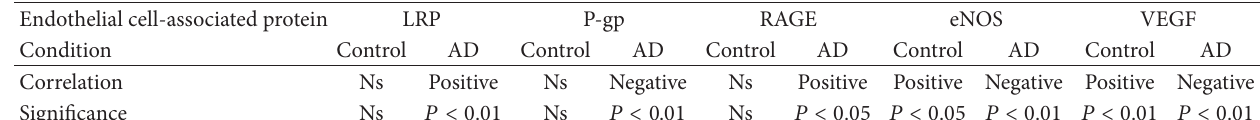
Table 3: A 𝛽 42 senile plaque and endothelial vasoactive proteins correlative data.